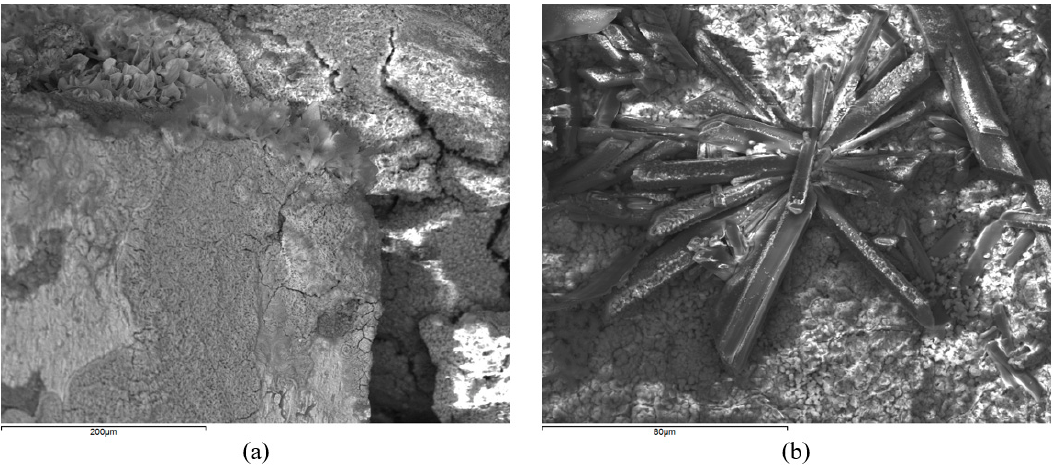
Figure 13. Microscopies performed on the cement mortar sample made with recycled concrete aggregate and cement / aggregate at a ratio of 1:3 at the age of 28 days: ( a ) Mortar matrix; ( b ) Ettringite